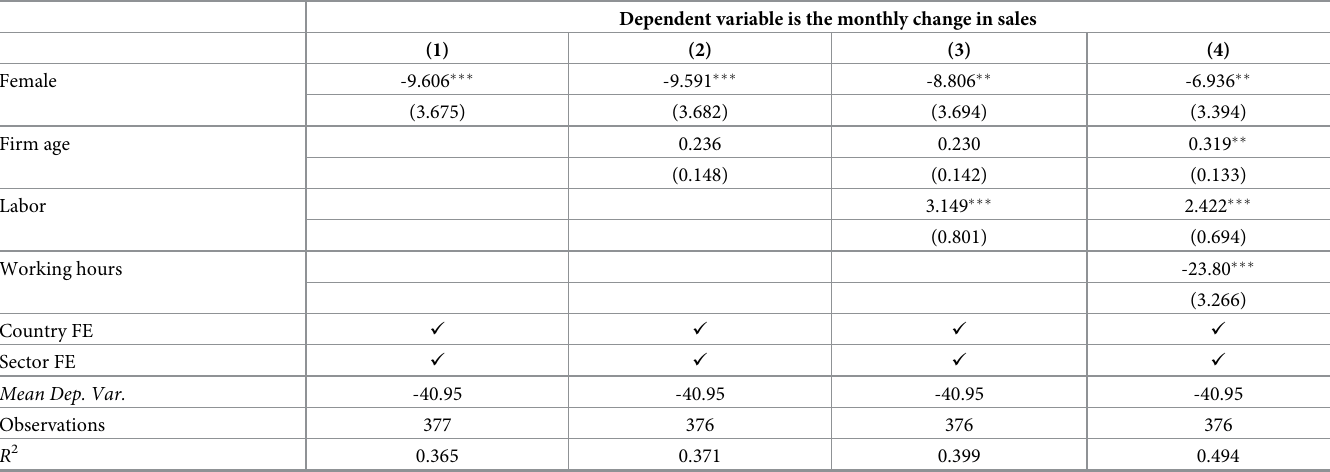
Table 11. External validity of the main results in the context of the COVID-19